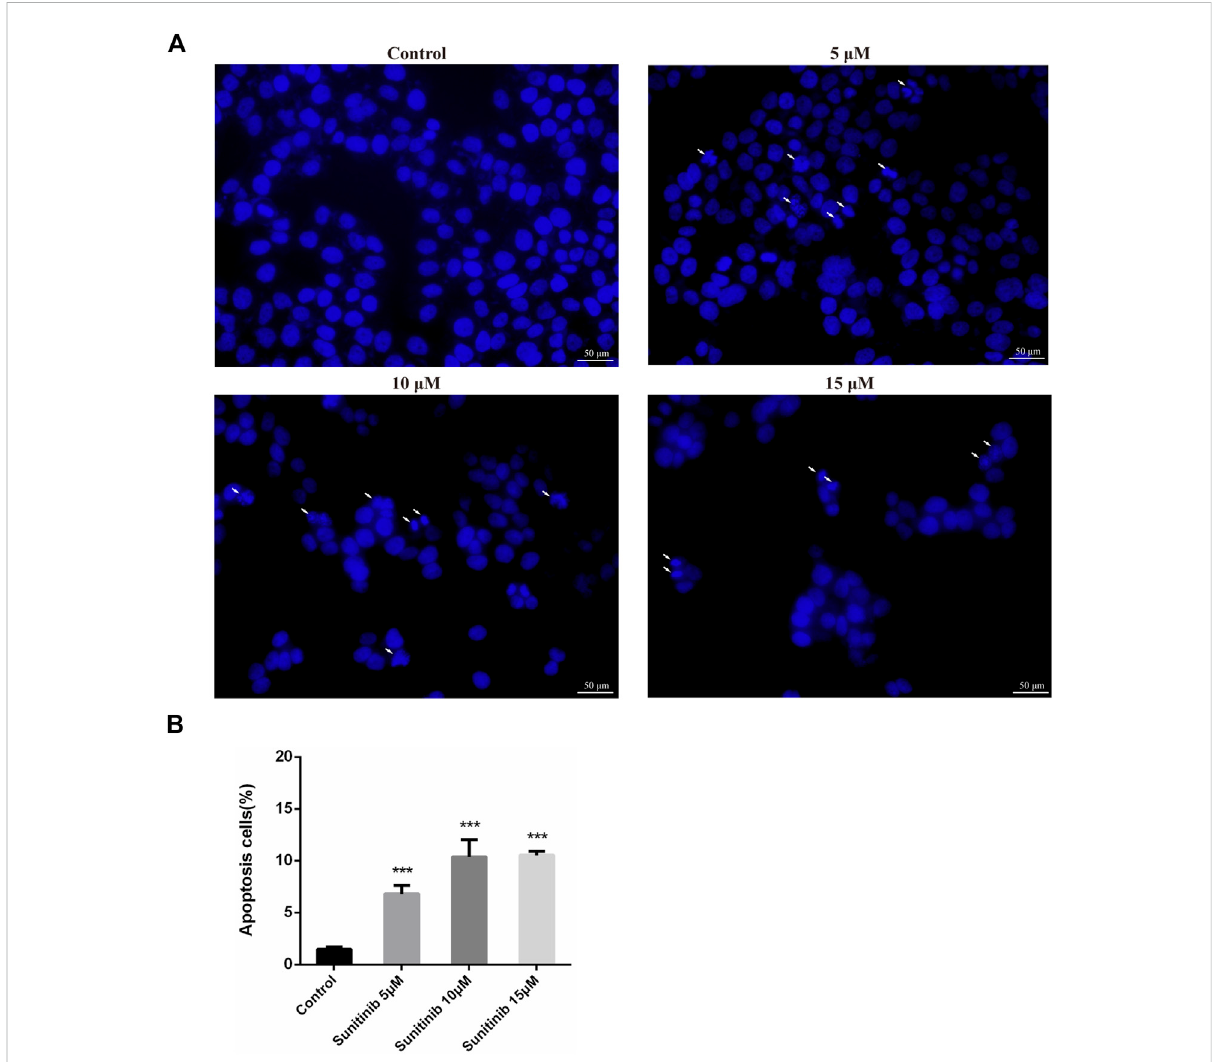
FIGURE 1 Sunitinib causes apoptosis in L02 cells. (A) Hepatocyte apoptosis was detected by Hoechst 33,342 staining in L02 cells. L02 cells were stained with Hoechst 33,342 after Sunitinib treatment at various concentration for 48 μ h, and nuclear changes were observed on fl uorescence microscopy (scale bars = 50 μ m). Insets white arrows denote apoptosis hepatocytes ( n = 3). (B) Quanti fi cation of apoptotic cells (%). *** p < 0.001 vs. Control